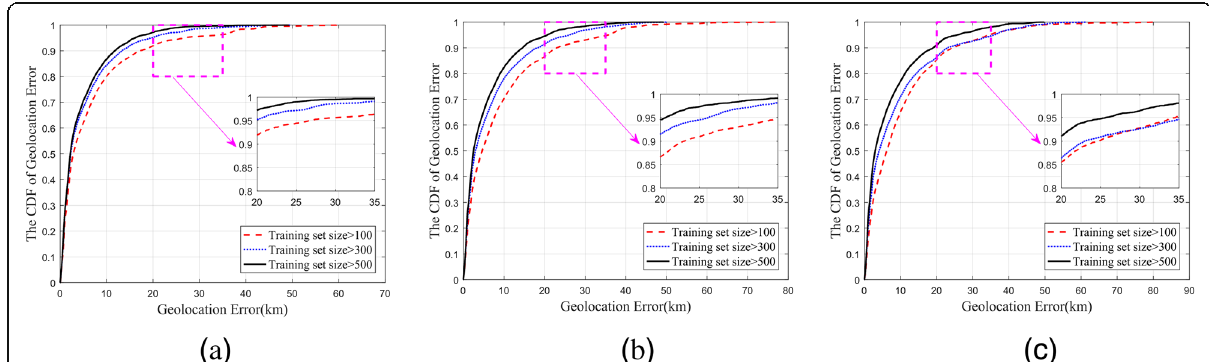
Fig. 4 The CDF (cumulative distribution function) of geolocation error under different training set sizes and thresholds. The red dashed line, blue dot line, and the black solid line indicate the cumulative error distribution of all neural networks formed by the training sets with the landmarks greater than 100,300 and 500 in each training set for the corresponding entities geolocation, respectively. a Threshold is 0.9. b Threshold is 0.8. c Threshold is 0.7